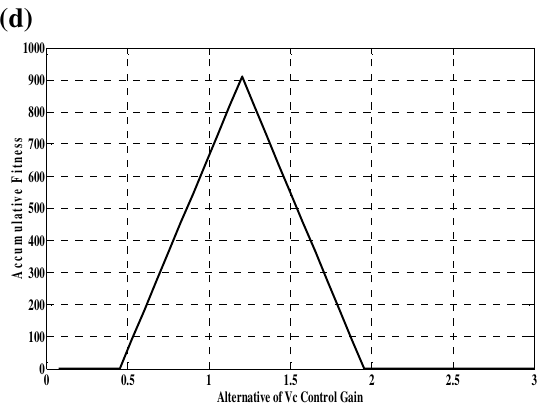
Fig. 9. The Accumulative fitness of the control gains: a) kp, b) ki, c) kd, d)